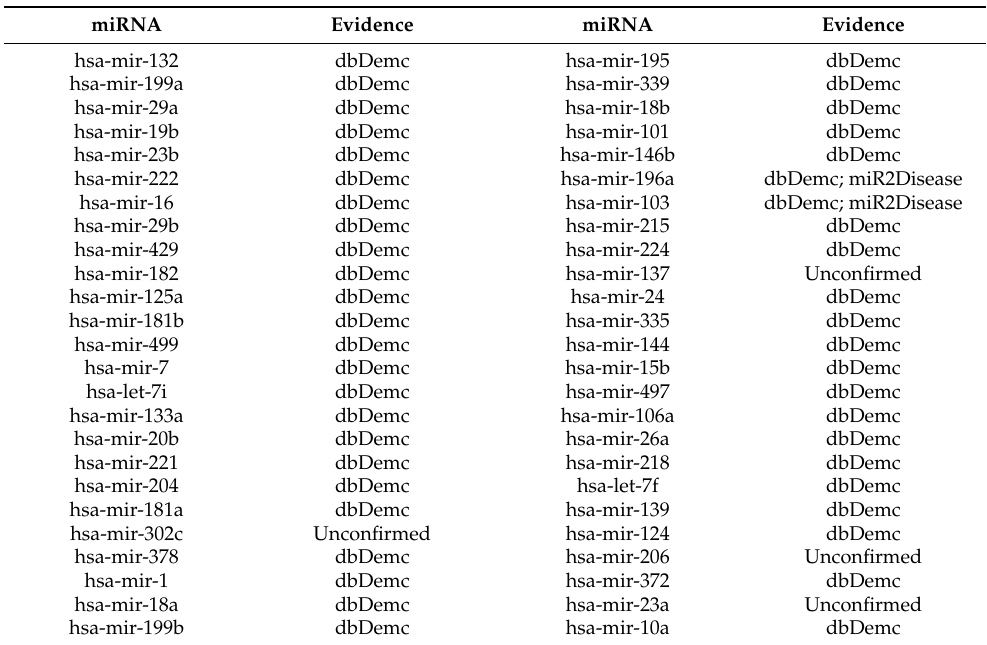
Table 7. Top 50 potential esophageal neoplasms-related miRNAs, 48 were confirmed by dbDEMC and miR2Disease